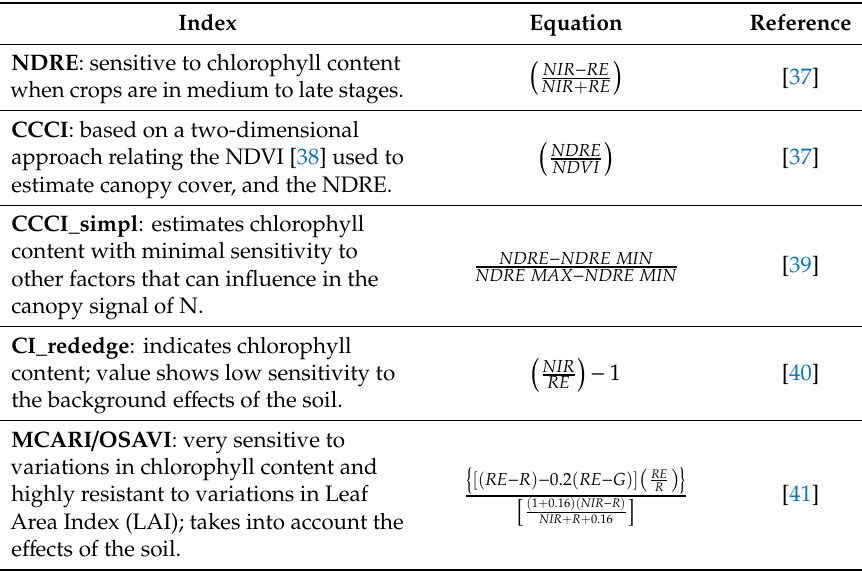
Table 1. Spectral indices are derived from aerial